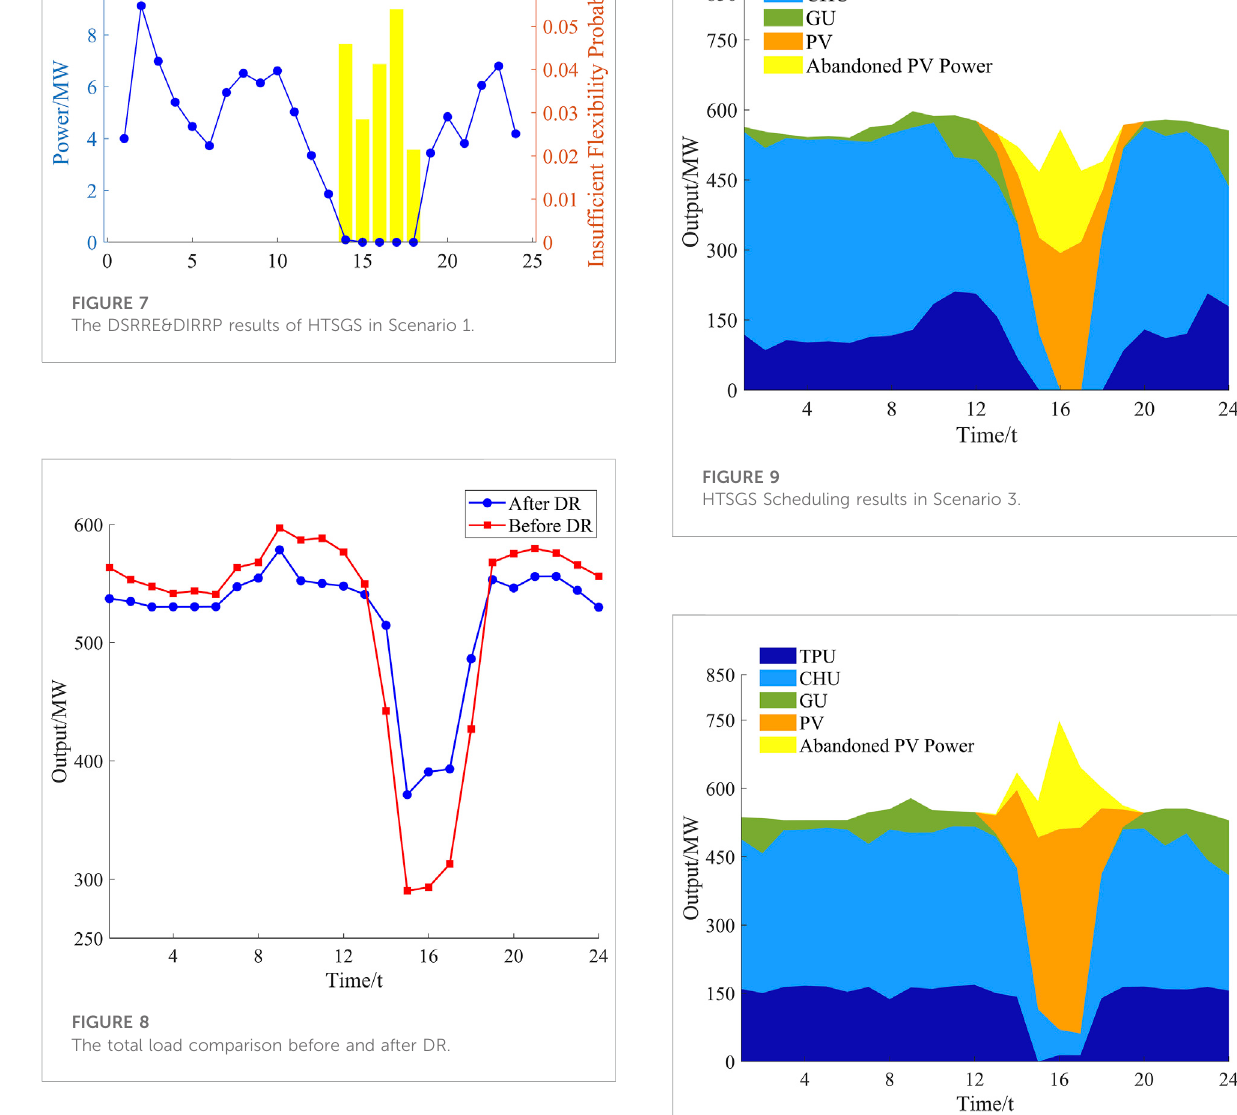
FIGURE 10 HTSGS Scheduling results in Scenario